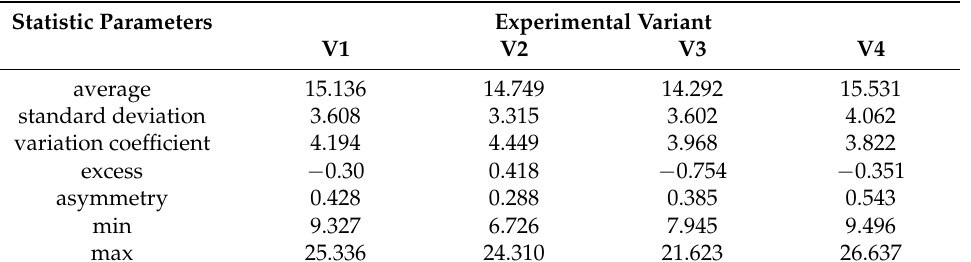
Table 3. General statistical parameters (average, standard deviation, variation coefficient—%, asym- metry, excess, minimum and maximum) for microdrilling resistance (%).